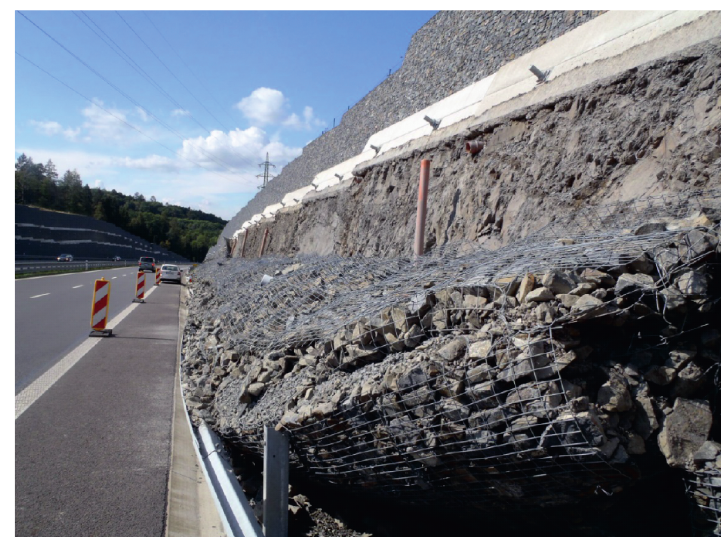
Figure 13. View of the collapsed gabion wall at the given location prior to the installation of the monitoring system.